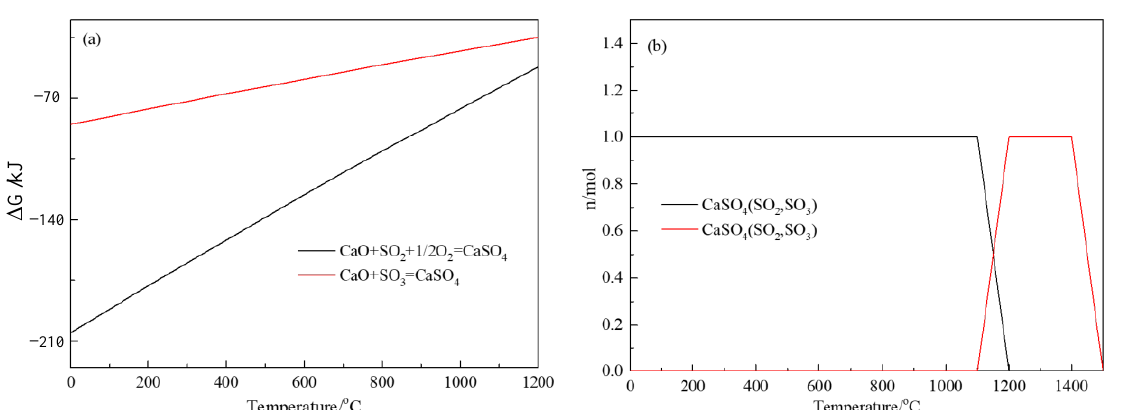
Figure 5. Predominance diagrams of various sulfate desulfurization systems ( a )Ca − S − O 2 ; ( b )Cu − S − O 2 ; ( c )Fe − S − O 2 ; ( d )Mg − S − O 2 .